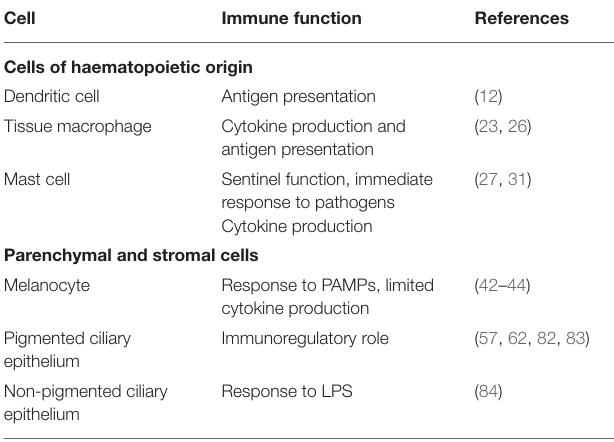
TABLE 2 | Summary table of the immune functions of ciliary body cell